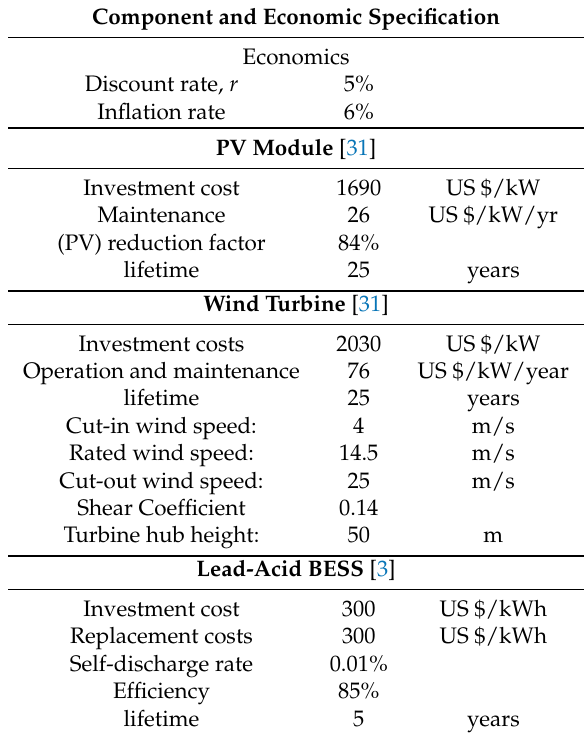
Table 1. Simulation parameters for the proposed